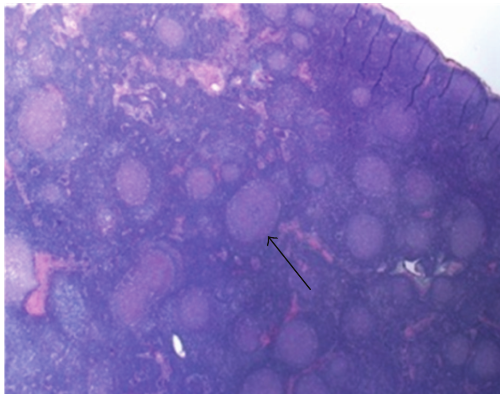
Figure 2: Hematoxylin and eosin stain of a resected lymph node, 2x magnification. This preparation shows nonspecific reactive follicular hyperplasia (arrow demonstrates secondary follicle with prominent germinal